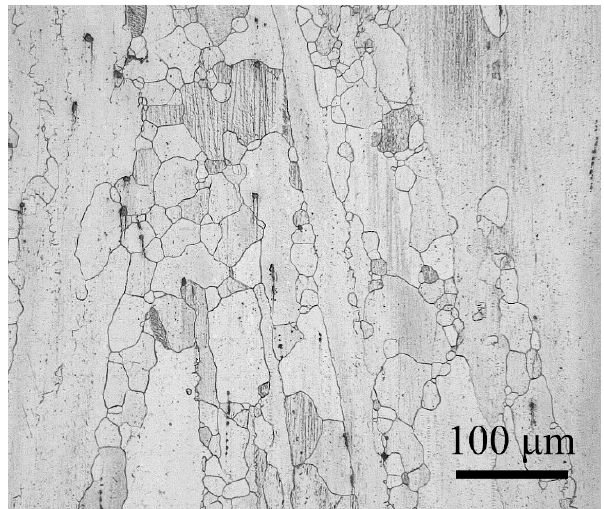
Figure 1. Metallographic microstructure of original AZ31 magnesium alloy rod.